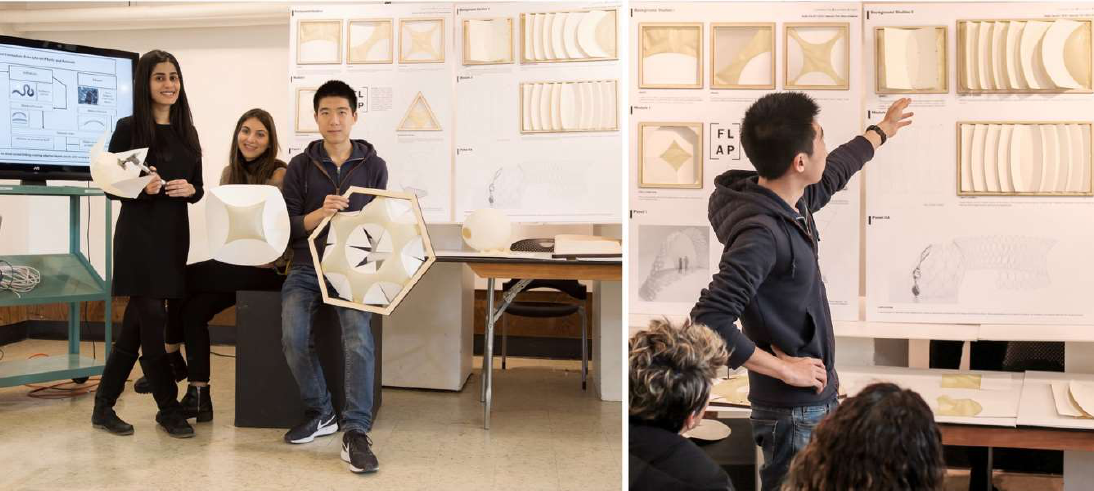
Figure 12. The students learned about the opportunities and limitations of different kinetic systems in various geometrical constellations through building functional models.